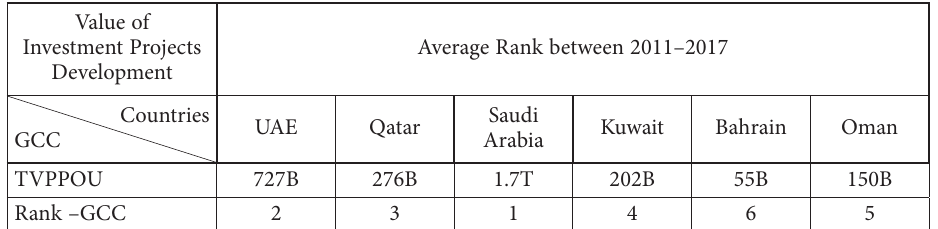
Table 1. Total value of projects planned or underway and rank (TVPPOU) US$-B, T (MEED) (source: